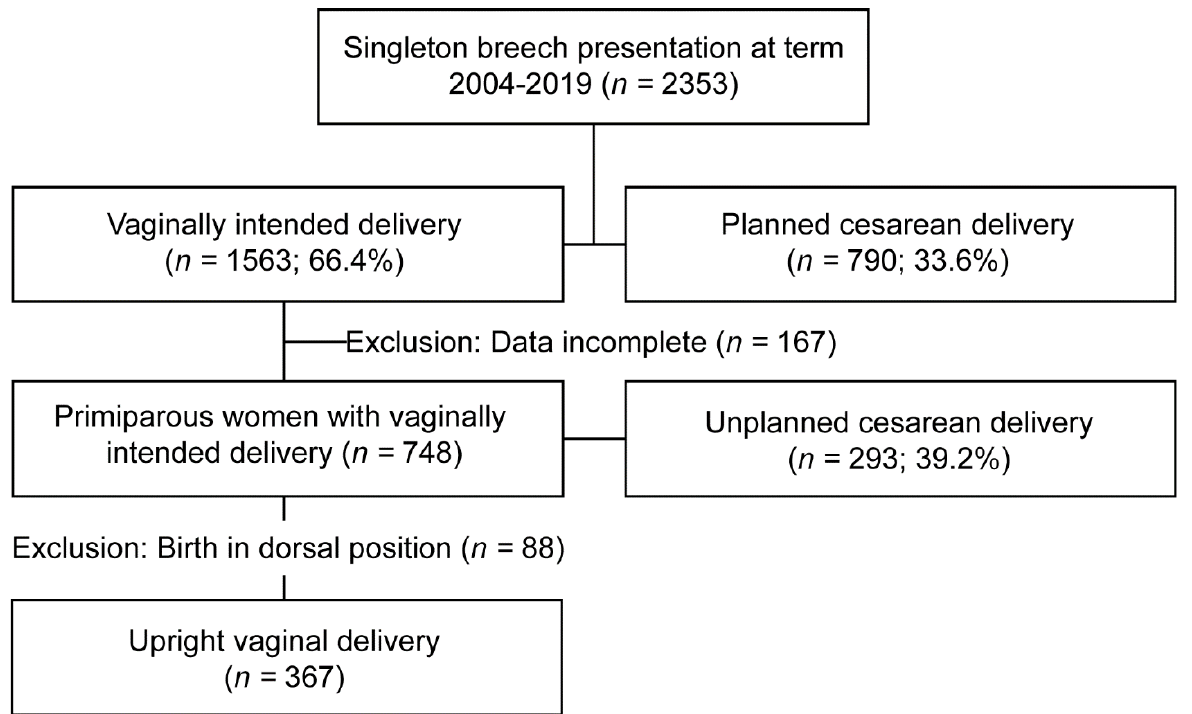
Figure 1. Flow Chart Study cohort. Table 1. Vaginally intended deliveries–Outcom in low ratio Group (LR) and high ratio group